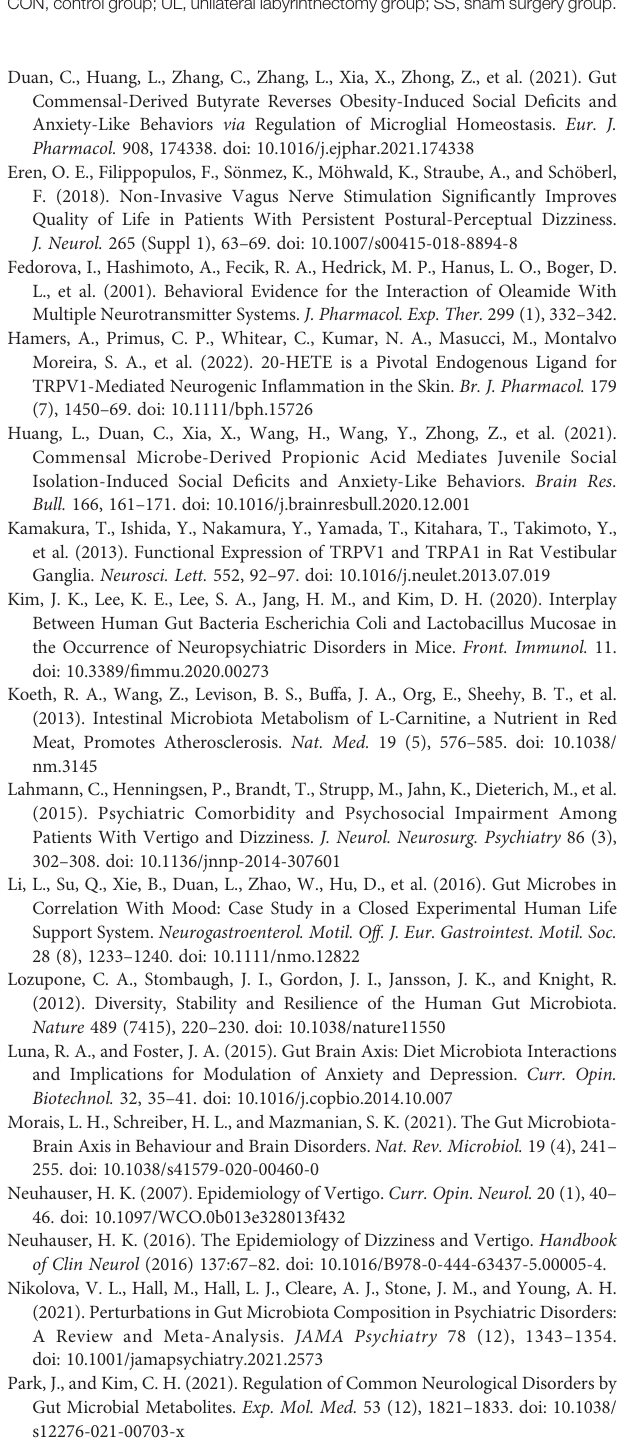
<0.05 and fold change ≥ 2 or ≤ 0.5. n= 5, per group. CON, control group; SS, sham surgery group. Supplementary Figure 5 | KEGG enrichment analysis of differential metabolites between the CON and SS groups (A) , and between the UL and SS groups (B) . UL: n = 6, CON: n = 5, SS: n = 5. KEGG, Kyoto Encyclopedia of Genes and Genomes; CON, control group; UL, unilateral labyrinthectomy group; SS,sham surgery